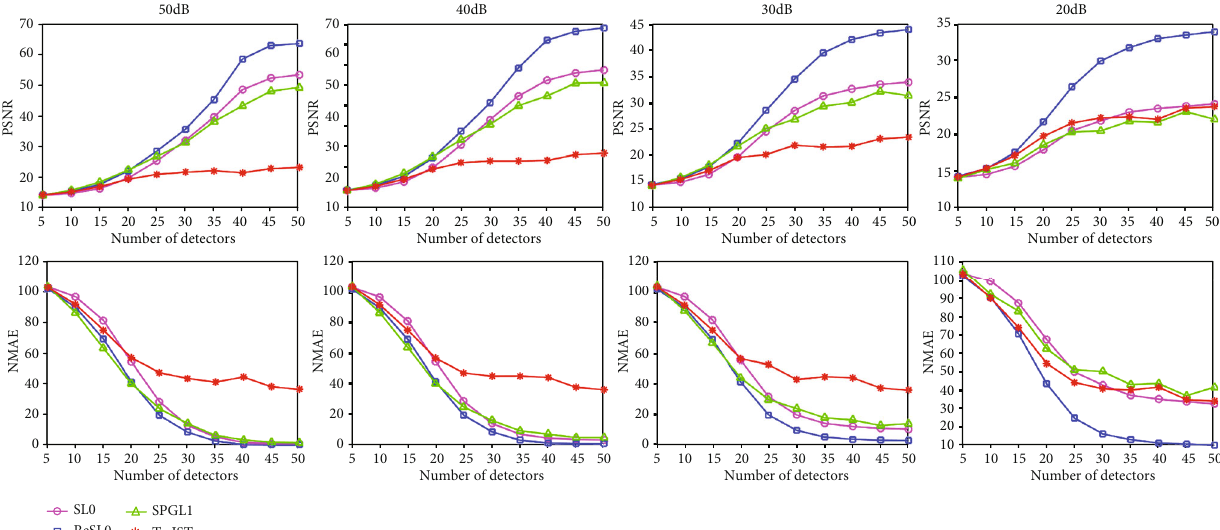
Figure 6: The PSNRs and NMAEs of reconstruction results of the blood vessel phantom with di ff erent number of sampling points. (a – d) The quantitative results of noisy observation with SNR = 50 , 40, 30, and 20 dB,